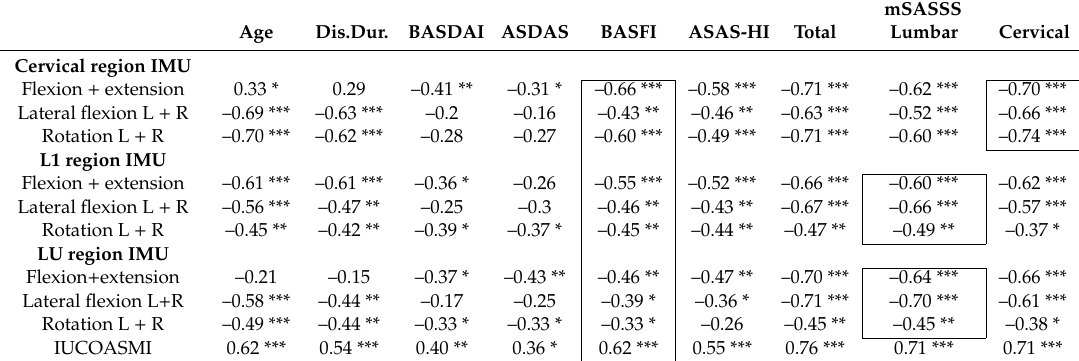
Table 5. Correlation between measures obtained by IMUs and other important